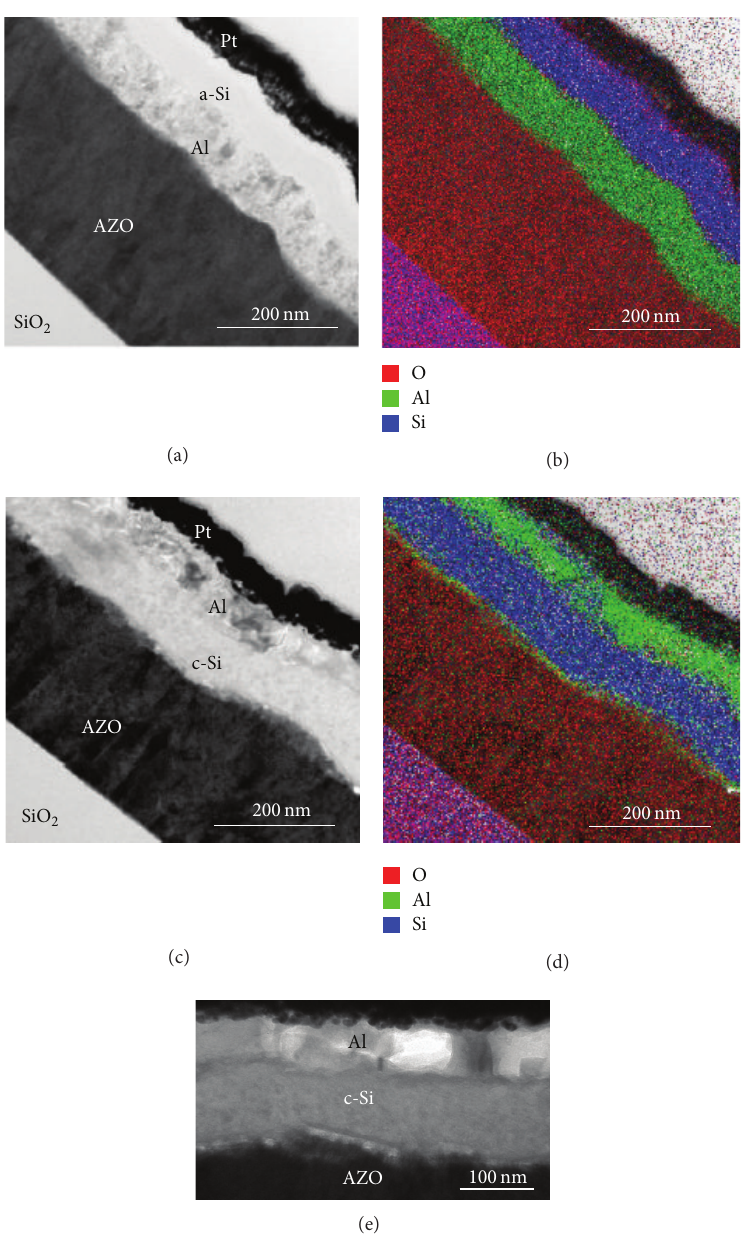
Figure 2: Cross-sectional TEM images and EDX maps for a sample with an AZO underlayer: (a, b) before and (c, d) after annealing (500 ∘ C, 5 h), indicating that layer exchange occurred. (e) Magnified TEM image of the sample after annealing.